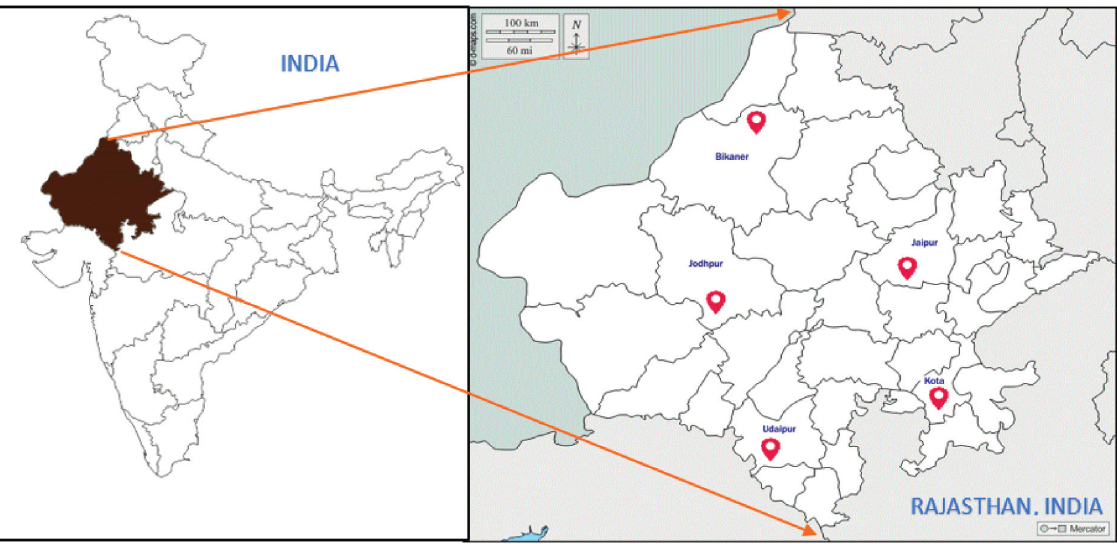
Figure 1: Map of the study area. % area of the